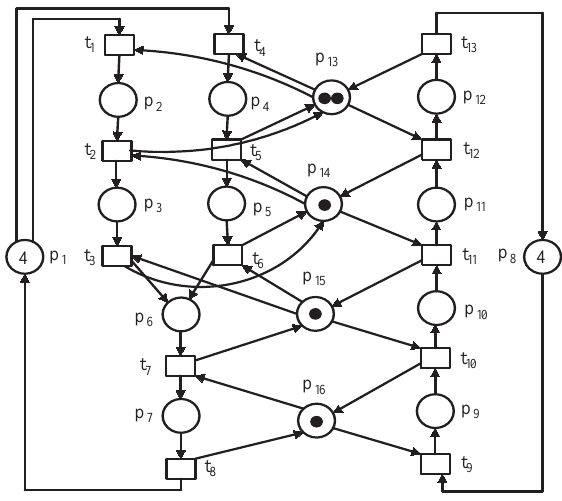
Figure 7. Petri net model for an FMS.